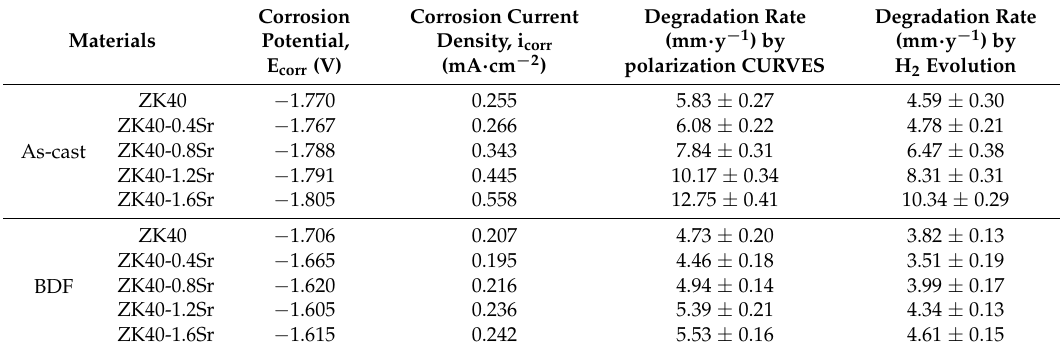
Table 1. Corrosion potential, corrosion current density, and degradation rate for the as-cast and BDF ZK40-xSr alloys in m-SBF at 37 ◦ C.